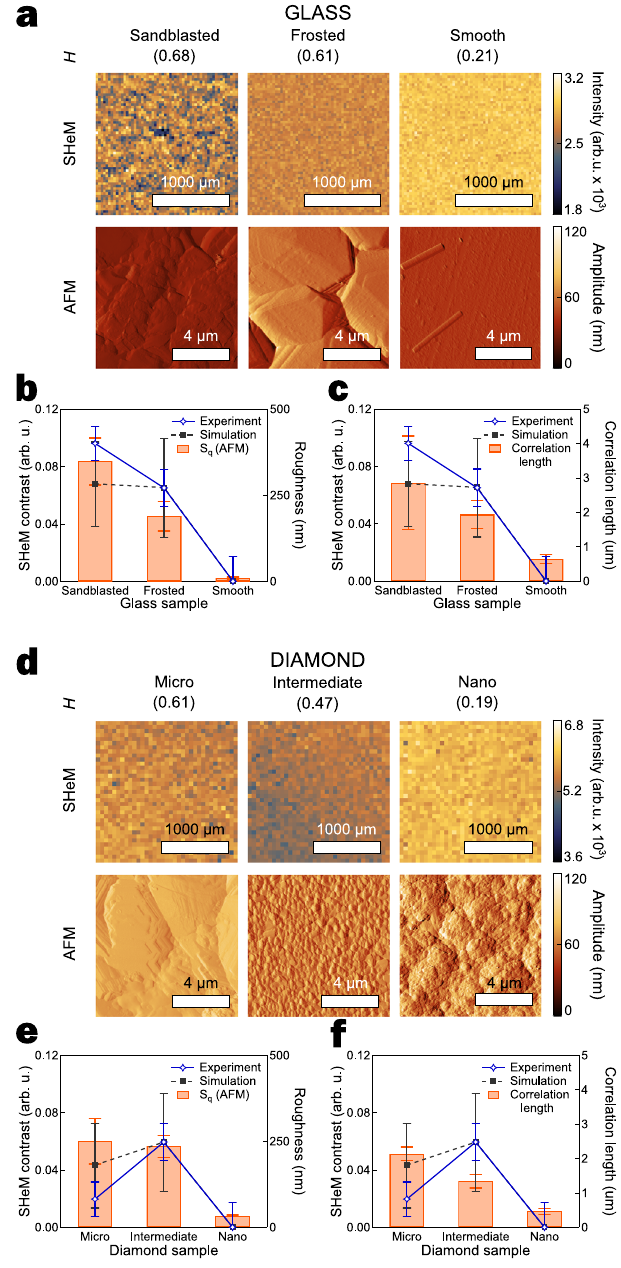
Fig.2|Comparisonoffacet-scatteringmodelandexperiment. AFM(amplitude) and SHeM micrographs of: a glass and d diamond surfaces for a range of surface fi nishes (summarised by the Hurst parameter H ). AFM scale bars are 4 µ m; SHeM scale bars are 1000 µ m. b and e Experimental SHeM Michelson contrast values (open stars) for the glass and diamond sample sets (respectively) as derived from themicrographsshownin a and d , along withsimulationresults(solid squares)for the same surfaces. Diamond surface contrast referenced to a silicon wafer; glass surface contrast taken with respect to the smooth (unaltered) glass sample. Errors in the experimental SHeM contrast are estimated using the standard deviation of themicrographintensitiesandstandarderrorpropagation.Standarddeviationsfor the simulated micrograph intensities were estimated via rotating the input map (see Methods),with the resultant errorsforcontrast following from standard error propagation. Areal RMS roughness ( S q ) was derived from the AFM micrographs of eachsurface (orange barchart),withassociated errorsfound by calculating the 2D RMS roughness for 5 different sub-regions of the AFM map and determining the standard deviation . c and f Comparison of the experimental and simulation con- trast results with the correlation length as derived from the AFM micrographs of eachsurface(orangebarchart).Thecorrelationlengtherrorbarsrepresentthe95% con fi denceintervalforthecalculation(seeSupplementaryDiscussion2fordetails).